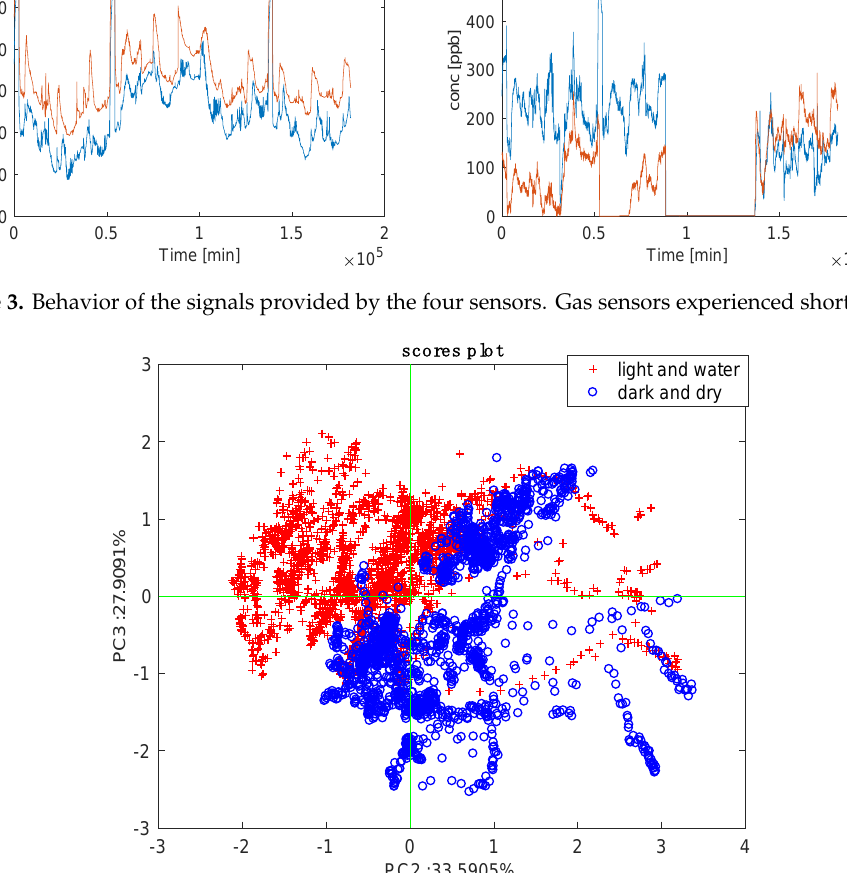
Figure 4. Principal component analysis (PCA) scores plot based on temperature, relative humidity, and total VOCs measured across 11 days.